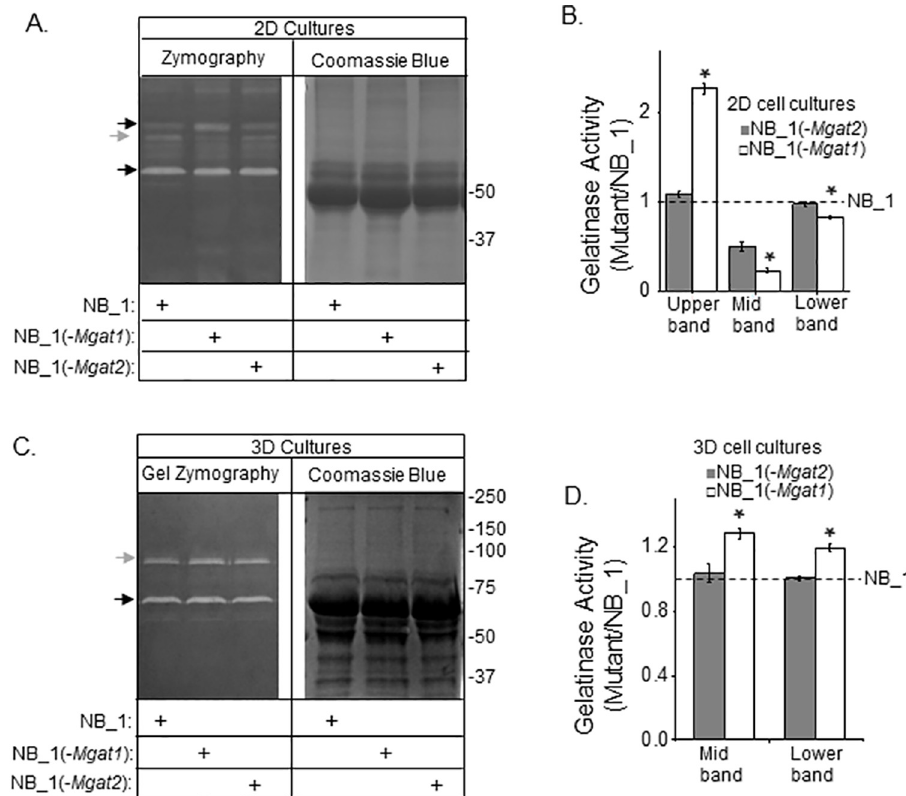
Fig 7. Gelatinase activity of 2D and 3D NB cell cultures. Gel zymography of conditioned serum-free medium samples from confluent plates (A) and spheroids cells (C) of NB_1, NB_1(- Mgat1 ) and NB_1(- Mgat2 ) cell lines (left panels). The amount loaded per well for 2D and 3D samples were 12 μ g and 3 μ g per well, respectively. Coomassie blue stained gels (right panels) of conditioned samples (10 μ g) were loaded per well. Black arrows adjacent to gels denote upper and lower bands while grey arrow signifies middle (Mid) band. Numbers adjacent to gels denote molecular markers. Bands from glycosylation mutant samples were normalized to those NB_1 for 2D (B) and 3D (D) cell cultures. Data are shown as the mean ± SEM and were compared by one-way ANOVA using Holm-Bonferroni post- hoc test ( � p < 0.05). n = 3 for upper, middle and lower bands from the various samples.